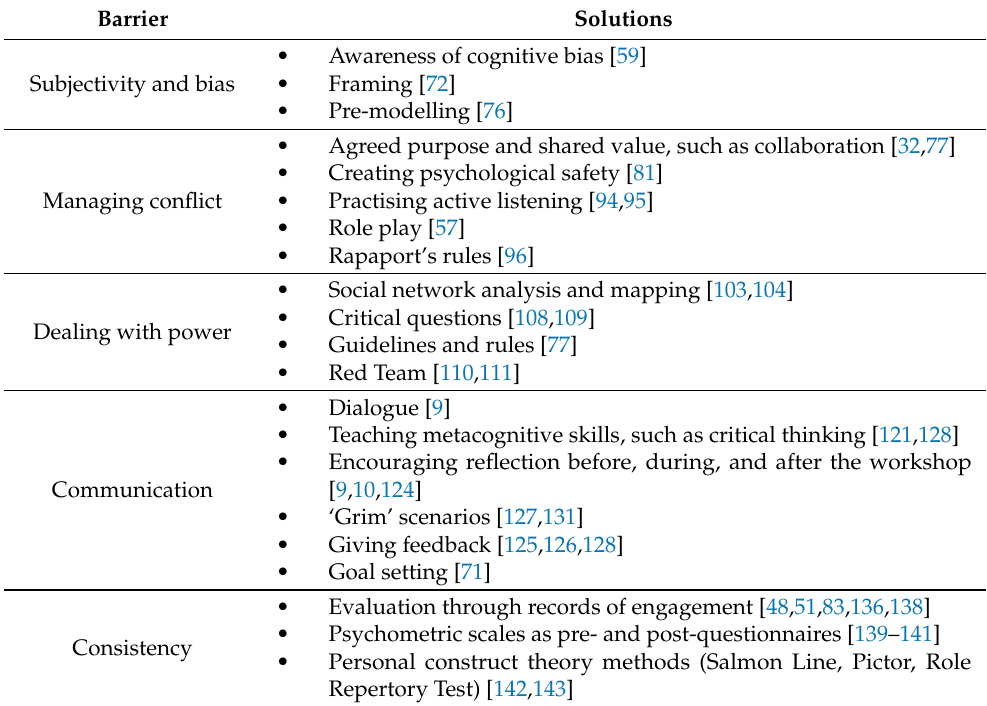
Table 1. Tools and resources that can be used to overcome the five barriers identified in this review. Barrier